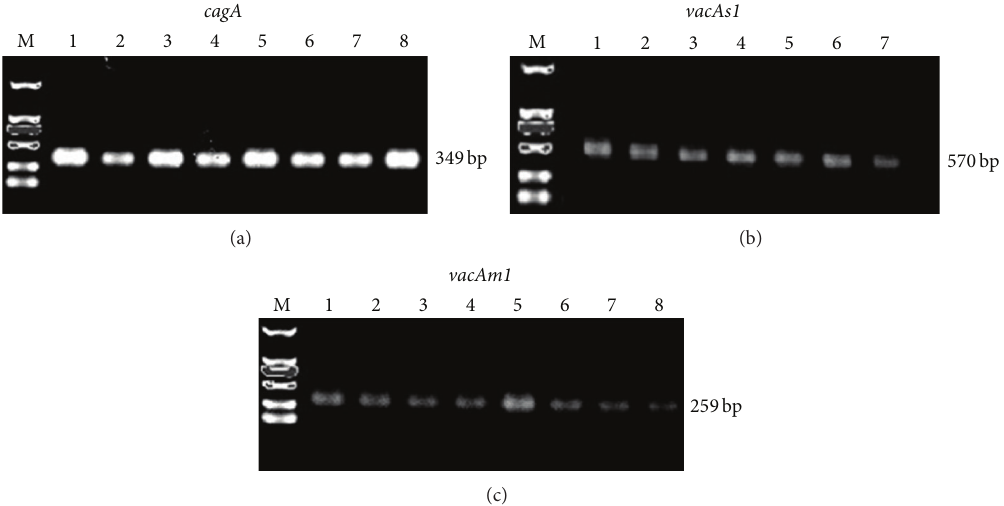
Figure 2: PCR amplification of (a) cagA , (b) vacAs1 , and (c) vacAm1 expression in H. pylori extracted from gastric mucosal tissue. Lane M, DNA marker; numbered lanes, samples with positive expression of the target genes. Base pair value indicates fragment of interest.